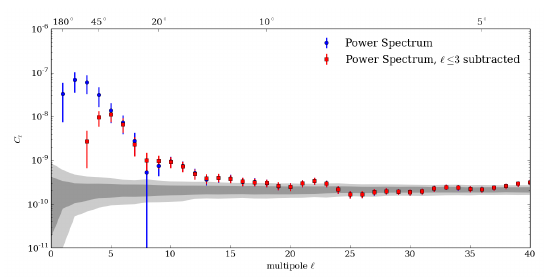
Figure 1: Angular power spectra of the unsmoothed relative intensity map before (blue) and after (red) subtracting the large– scale structure ( (cid:26) 3). Gray errors bands show the 68% and ≤ 95% spread of the C (cid:26) for isotropic data sets. Comparing the band to the data shows which ell -modes significantly contribute to the sky map. The error bars on the C (cid:26) are the square root of the variances returned by a fit using PolSpice .